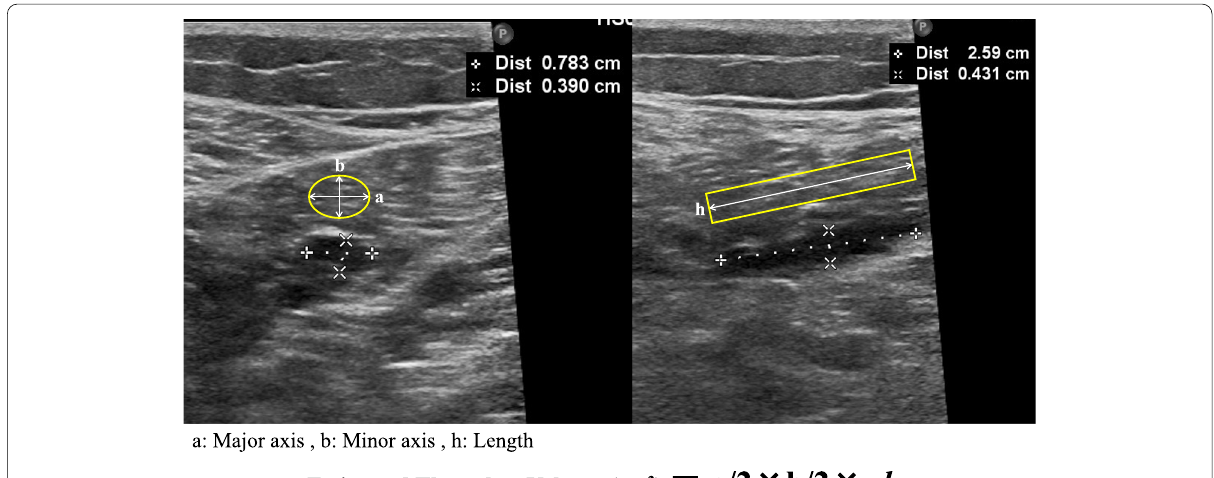
Fig. 1 Method for estimation of thrombus volume. Thrombus volume was calculated by approximation of the value determined by